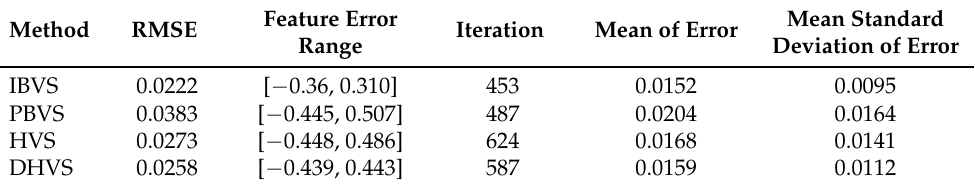
Table 1. Performance of visual servoing methods in the image space.